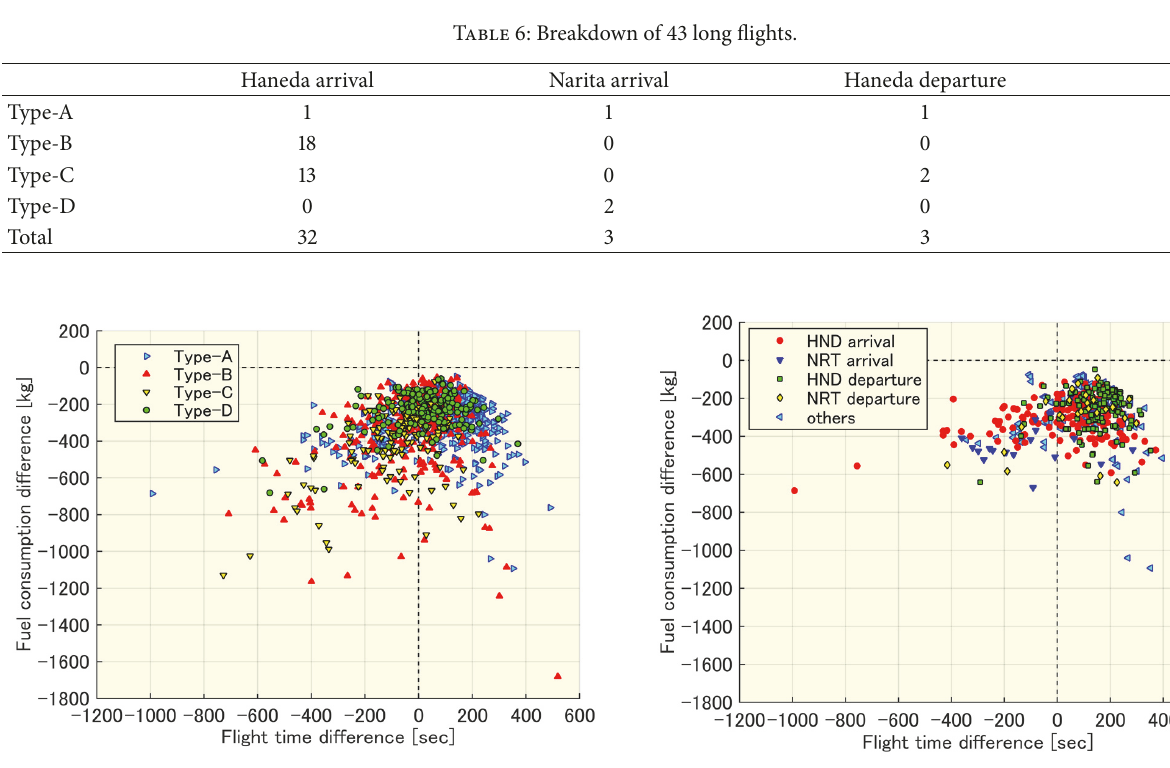
Figure 6: Fuel difference of the optimal trajectories relative to the original flights (1087 cases).